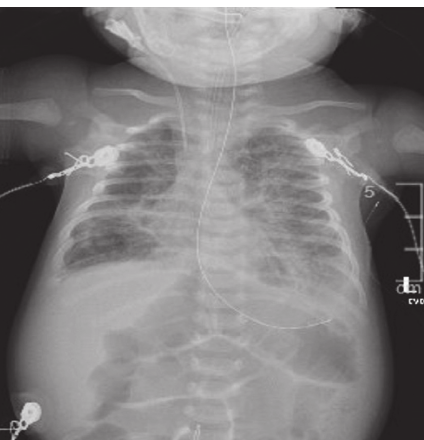
Figure 1: Initial chest X-ray showing bilateral pulmonary edema with left pleural effusion.